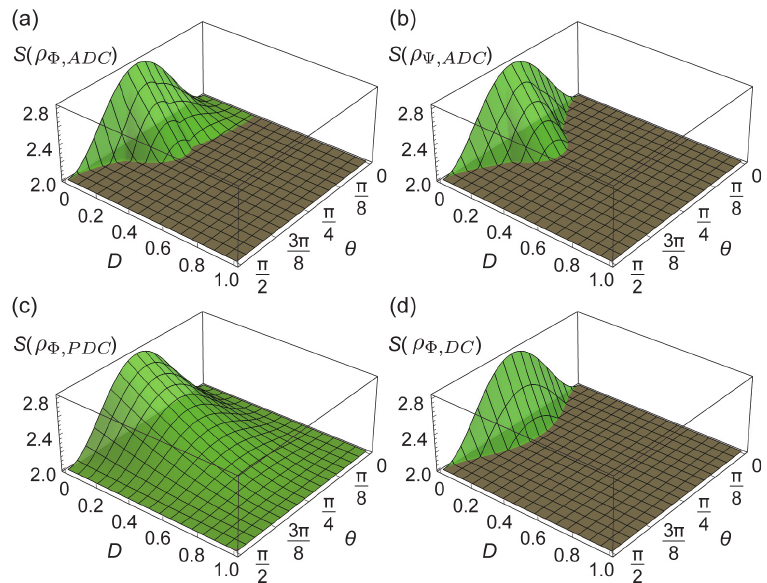
Figure 3. Theoretical results of Bell parameter (Green) as functions of D (= D A = D B ) and θ for ( a ) ρ Φ , ADC , ( b ) ρ Ψ , ADC , ( c ) ρ Φ , PDC , and ( d ) ρ Φ , DC . Above S = 2 planes indicate the existence of Bell nonlocality. BNSD occurs when the entangled state is under ADC, and